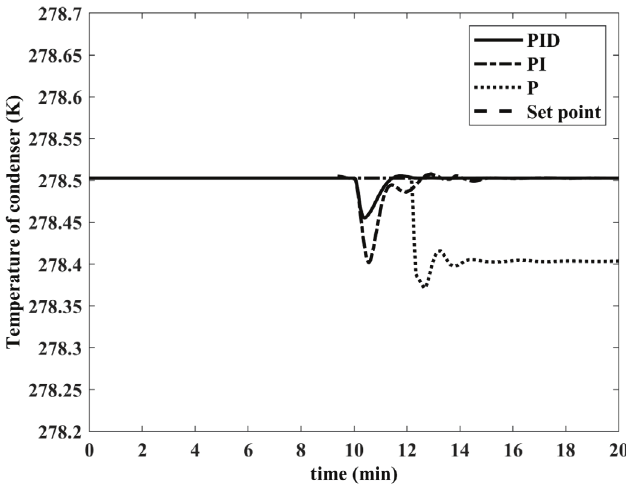
Fig. 9 – Performance of different controllers for rejection of disturbance in propylene feed flow